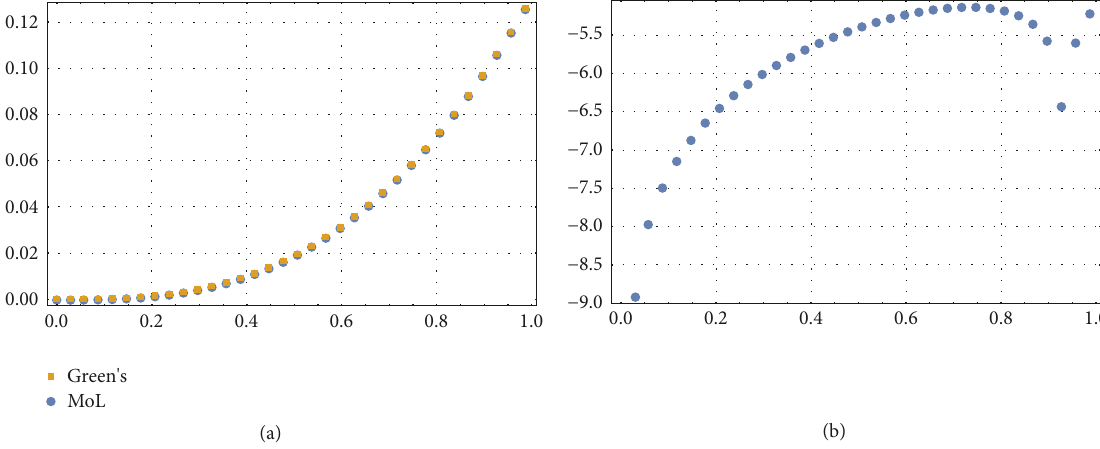
Figure 12: Discrete plot of 𝑤 and 𝑤 MoL (a) and Er (b) against 𝑡 ∈ [0,1] for 𝑓(𝑡) = ln (1 + 𝑡) : hyperbolic Green’s